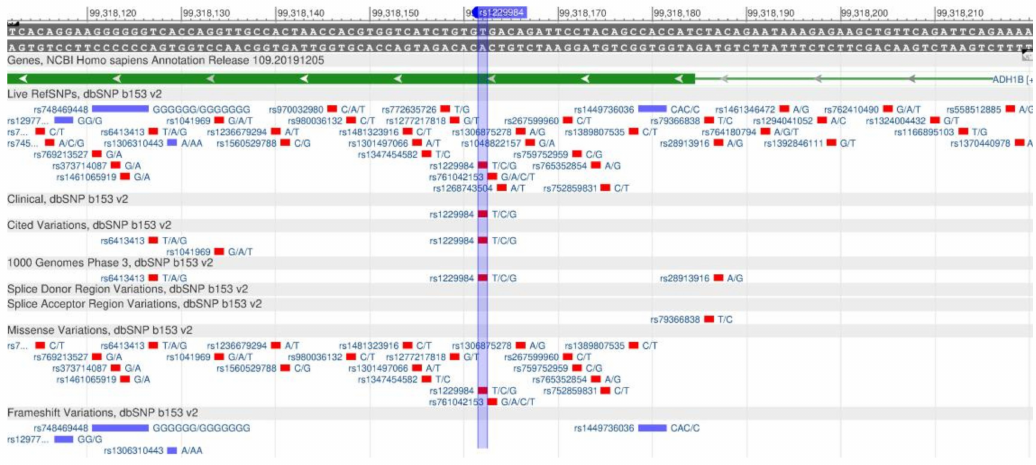
Figure 36. A portion of the ADH1B gene (located on the long (q) arm of chromosome 4) containing the oligonucleotide polymorphism